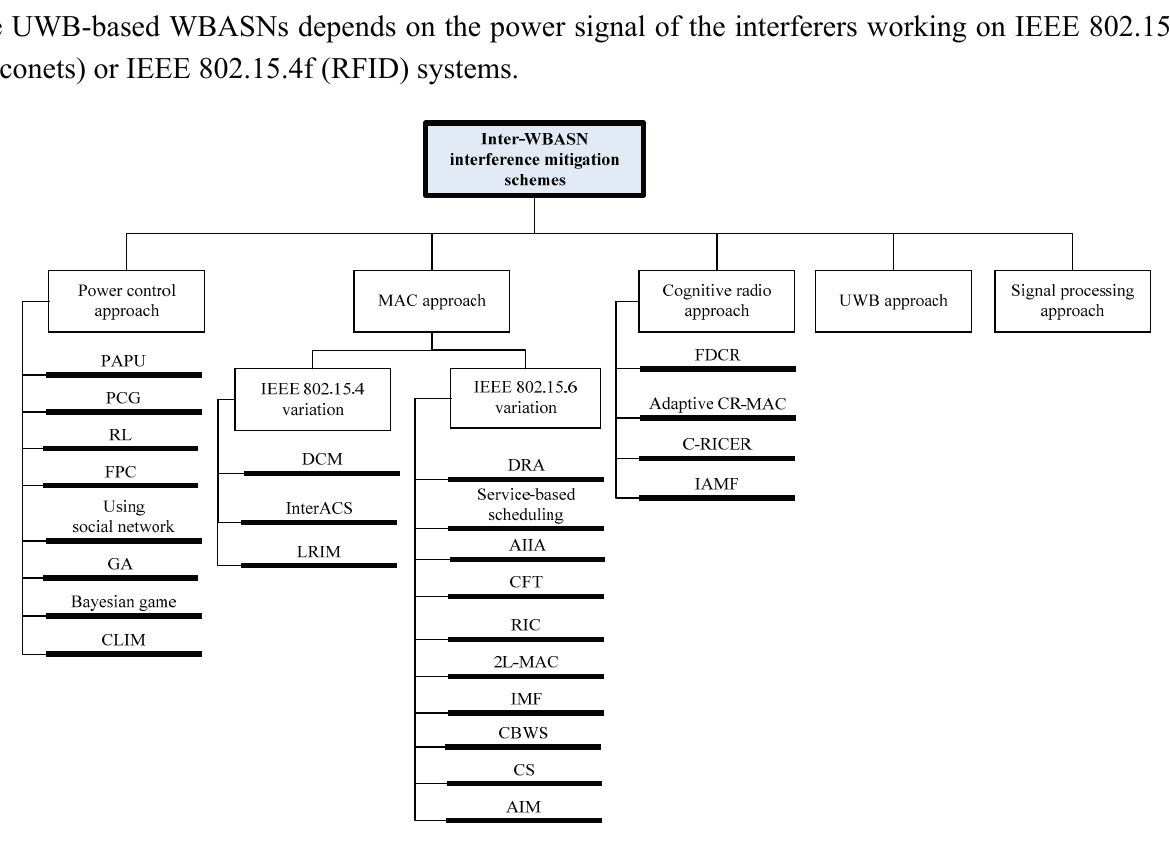
Figure 2. Categories of inter-WBASN interference mitigation